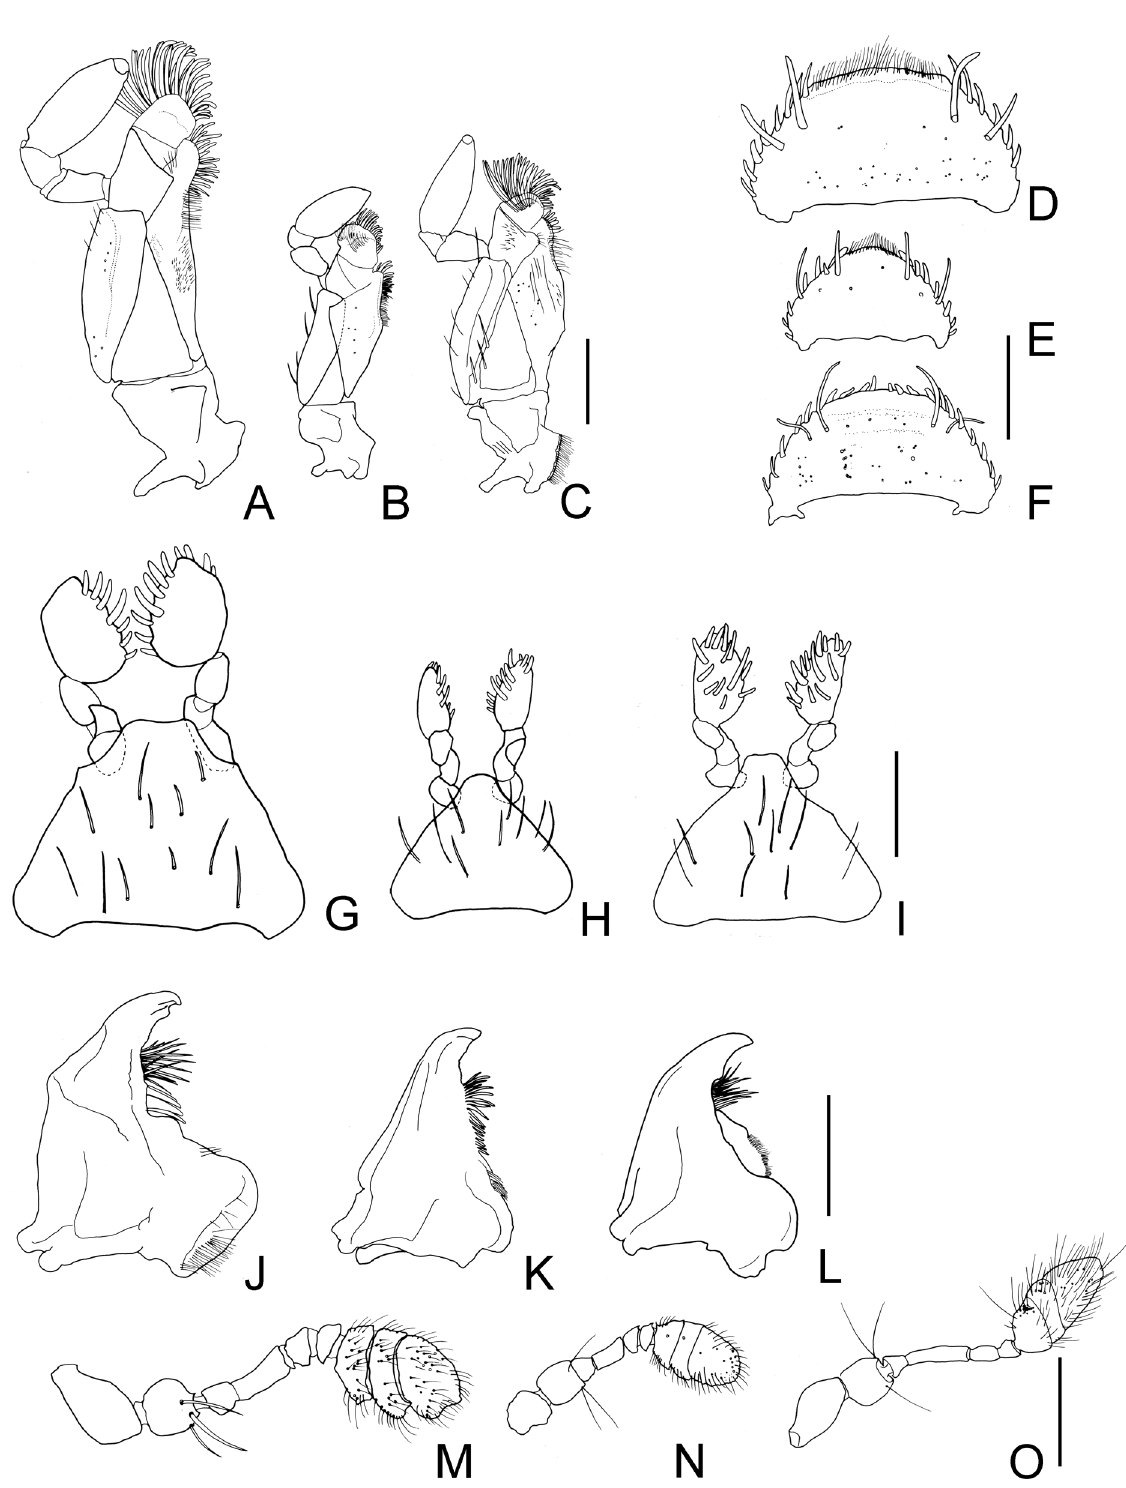
Fig. 4. Mouth parts and antennae of Georissus spp. A–C . Left maxillae. D–F . Labrum. G–I . Labial palpi. J–L . Left mandibles. M–O . Left antennae. A, D, G, J, M . G . ( G .) canalifer Sharp, 1888. B, E, H, K, N . G . ( Ni .) granulosus Satô, 1972. C, F, I, L, O . G . ( Ne .) japonicus Satô, 1972. Scale bars = 0.1